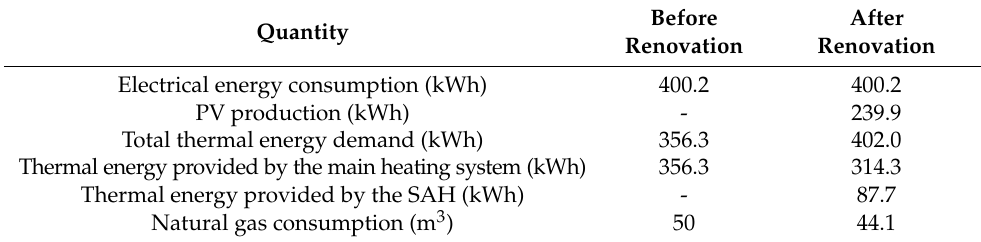
Table 5. Annual energy outputs before and after the installation of the Welsh site